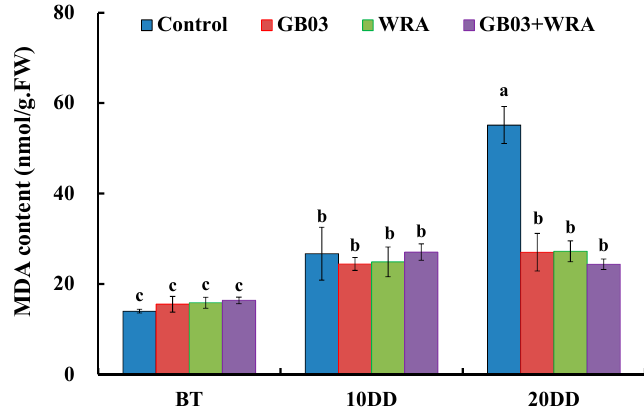
Figure 7. Effects of GB03, water retaining agent (WRA), or the combination of GB03+WRA on leaf malondialdehyde (MDA) content of ryegrass. BT, before treatment (20-day-old seedling); 10DD, 10-day natural drought; 20DD, 20-day natural drought; 7DR, 7 days after rewatering. Values are means and bars indicate SEs ( n = 12). Columns with different letters indicate significant differences among treatments at p < 0.05 (ANOVA and Duncan’s post-hoc multiple comparison test).